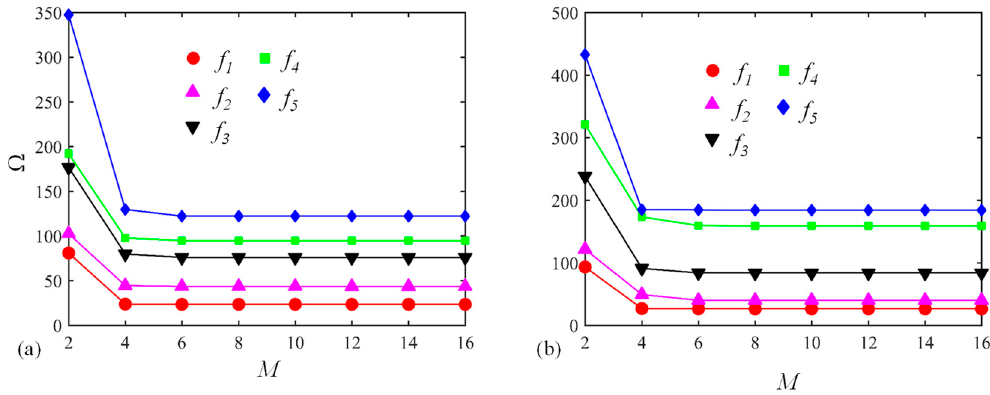
Figure 5. Dimensionless frequency Ω versus truncation terms M for ( a ) a circular CLCB and ( b ) an elliptical CLCB with C-C boundary condition.